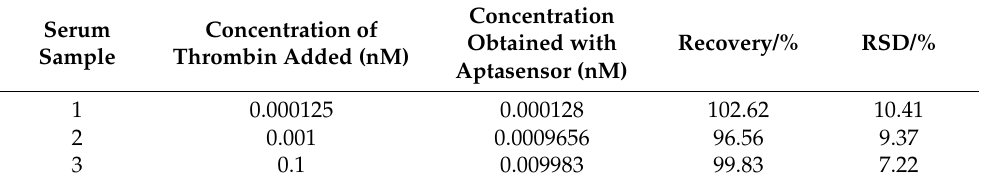
Table 3. Detection of thrombin in human blood serum (the number of samples was